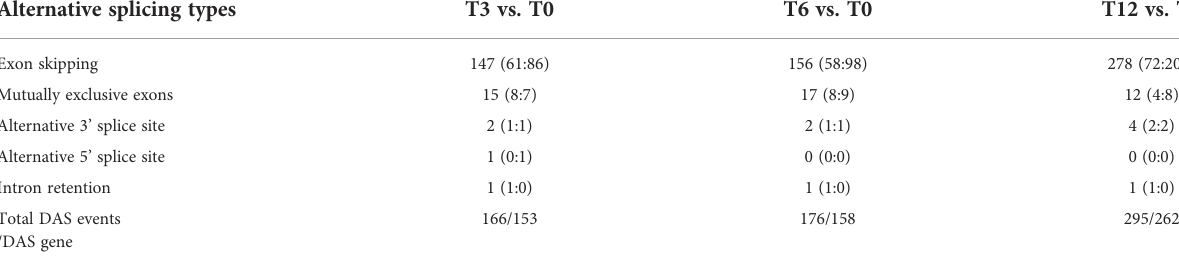
TABLE 1 Statistics of DAS events detected in gills after hypoxia.